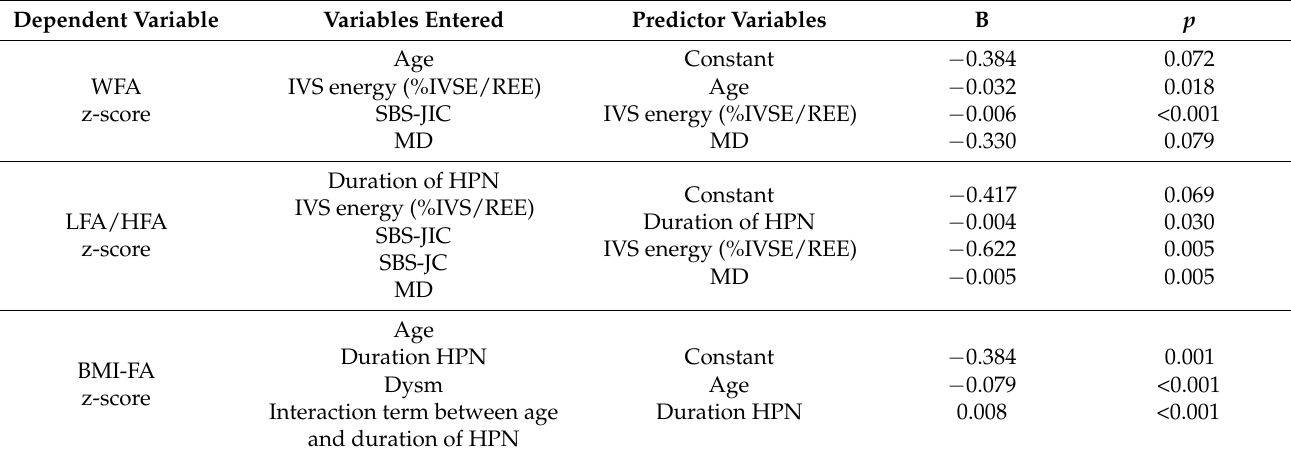
Table 2. Multivariate analysis of factors associated with nutritional status parameters (z-scores).